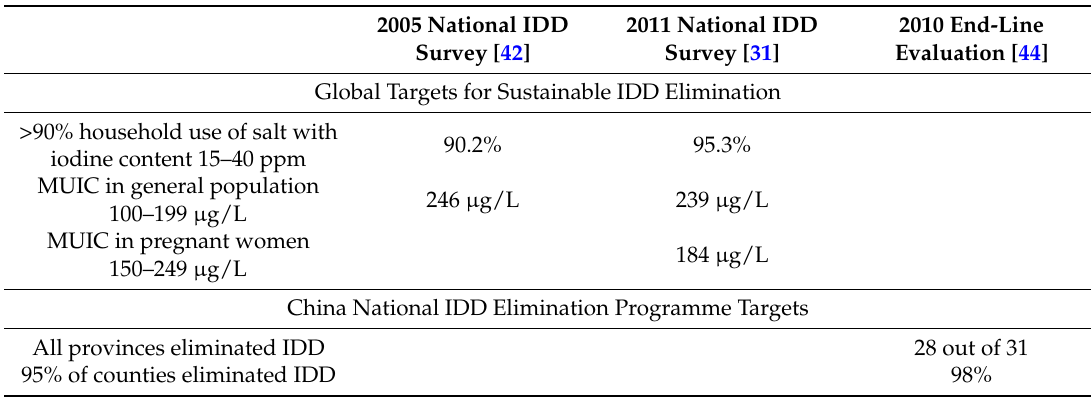
Table 3. Achievements of the Chinese IDD Elimination Programme against global and national targets